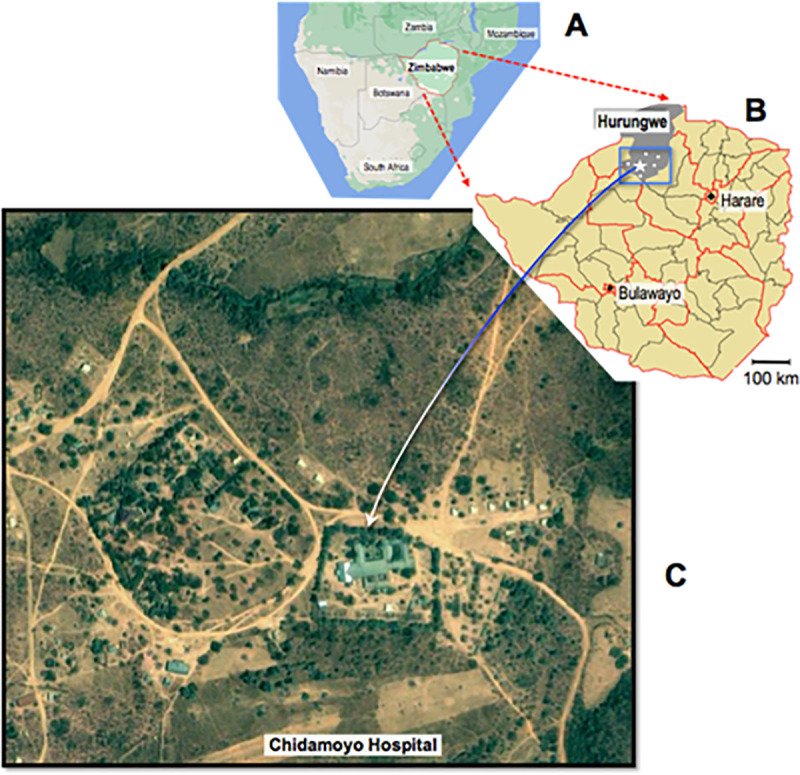
Hurungwe district in Northwestern Zimbabwe.A-map of the Southern part of Africa showing Zimbabwe and surrounding countries; B-map of Zimbabwe showing the Hurungwe District in the Northwestern part of Zimbabwe. The approximate location of Chidamoyo Christian Hospitalis indicated by the white star and the relative locations of five outpatient sites (Batanayi, Magororo, Chedope, Nyamutora, and Zvarai) are indicated by white circles; C-the arrow is pointing to Chidamoyo Christian Hospital. This figure was downloaded online from the Humanitarian Response info website (https://www.humanitarianresponse.info/sites/www.humanitarianresponse.info/files/ZWE).